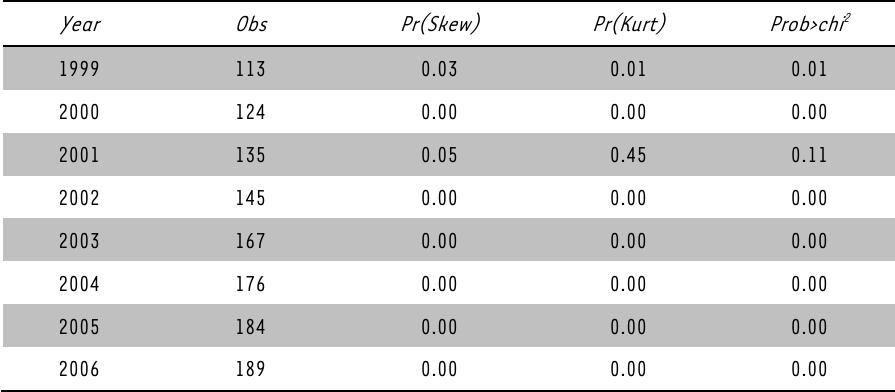
TABLE 1: Jacque-Bera test for